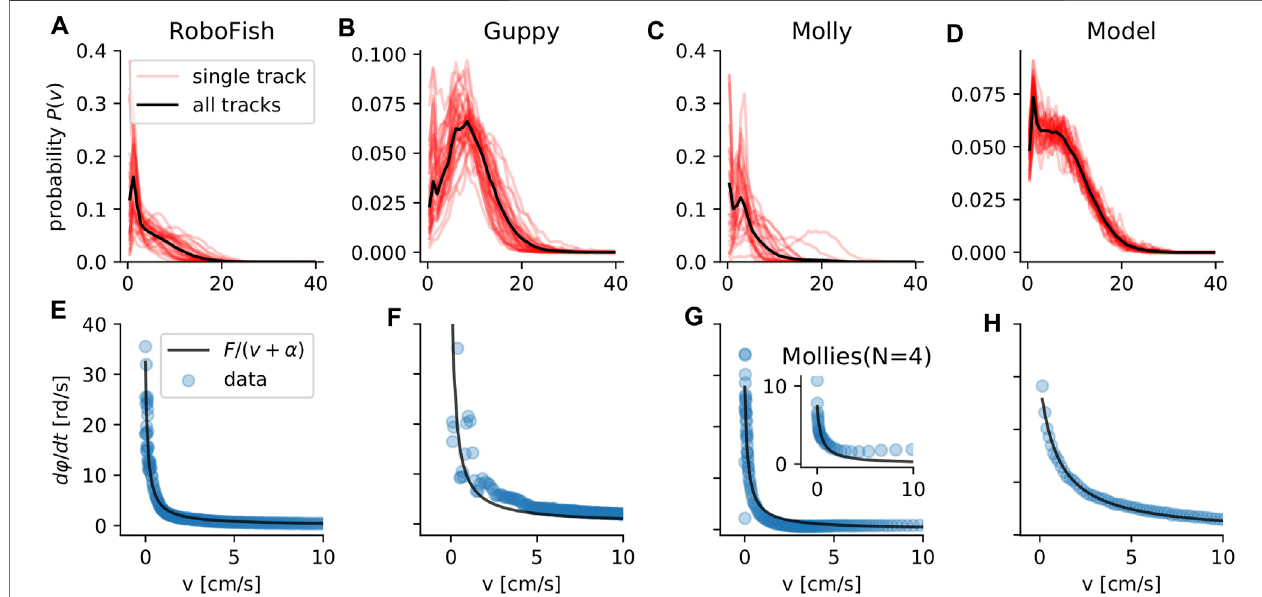
FIGURE 2 | Speed and turning of individuals. The speed probability distributions P ( v ) for the experimental data (RoboFish, guppy, molly) and for model simulations of individuals (A – D) . Red transparent lines represent single tracks and the solid black line is the distribution of all tracks summarized. The absolute turning rate _ φ as a function of the speed v for the different individuals (E – H) . For mollies we also show the relation between turning rate speed of individuals swimming in groups of N (cid:1) 4 (inset G ).Theparametersofthemodelsimulations(describedin Section2.5 )arelistedin Table2 ; SupplementaryTableS5 withthedifferenceofaturnfrictionof α (cid:1) 0.1. The parameters of the model fi ts in Supplementary Table S4 .